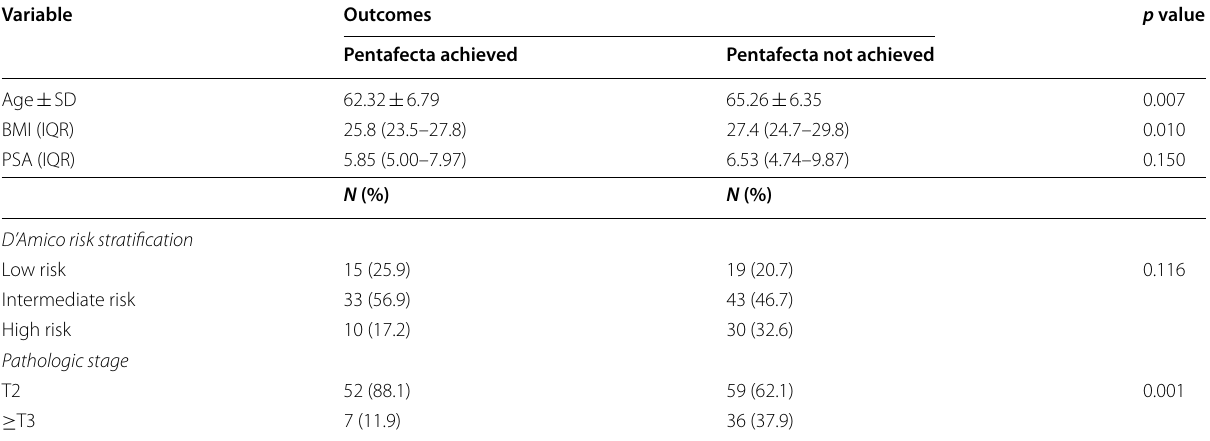
Table 4 Analysis of factors related to pentafecta Variable